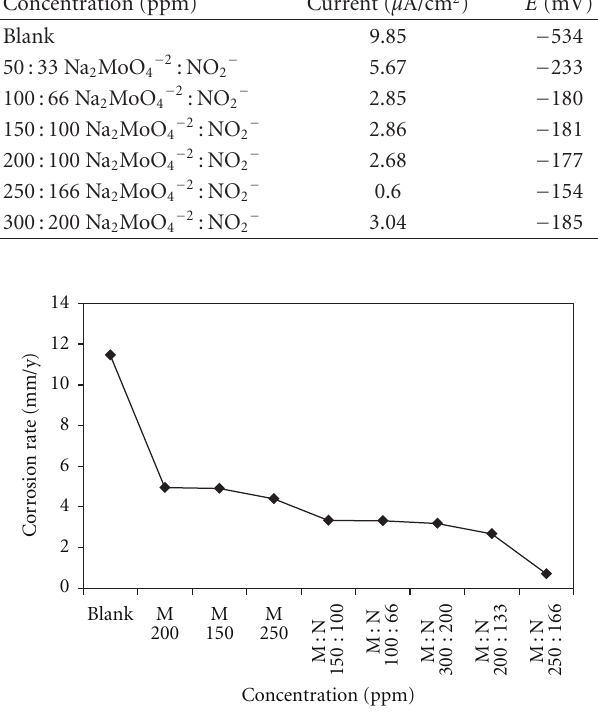
Figure 6: Corrosion rate of Cu-CS galvanic couple in function of the molybdate-nitrite ratio in RO water solutions.